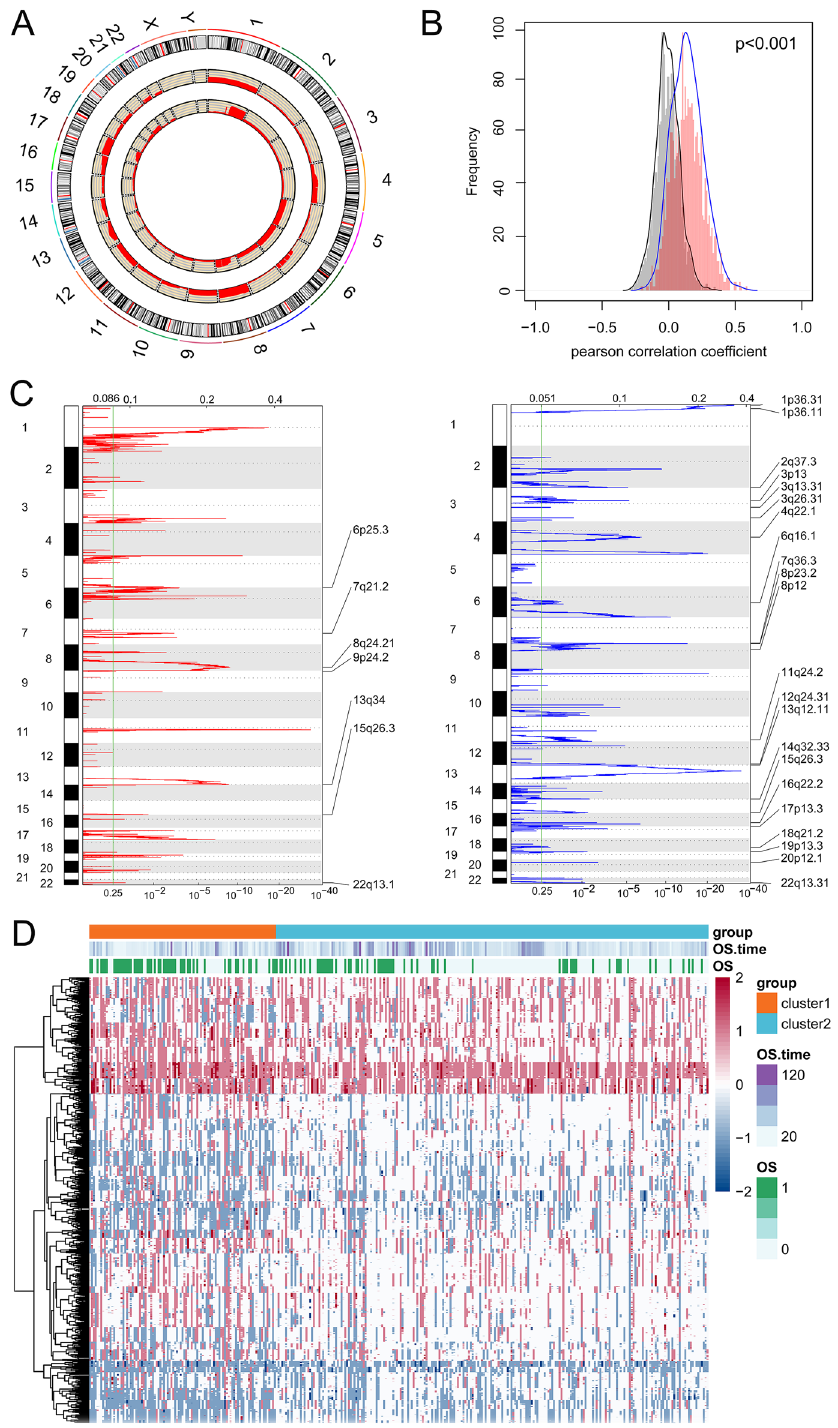
Figure 4. Genomic copy number anomalies and their relationship to lncRNAs. ( A ) Distribution of lncRNA copy number gain and loss in the genome. The innermost layer indicates copy number gain, the second layer indicates copy number loss, and the red height indicates variation frequency. ( B ) The correlation distribution between lncRNA expressions and copy number variation (CNAs), grey represents the distribution under random conditions, orange represents the distribution under actual conditions. ( C ) The lncRNAs located in the focal CNA peaks. False-discovery rates and scores from GISTIC 2.0 for alterations (x-axis) are plotted against genome positions (y-axis); dotted lines indicate the centromeres. The losses (right, blue) and gains (left, red) of lncRNAs genes are also shown. ( D ) Heatmap of CNA in lncRNA. Blue dot indicates loss, red dot indicates gain, and white dot indicates no